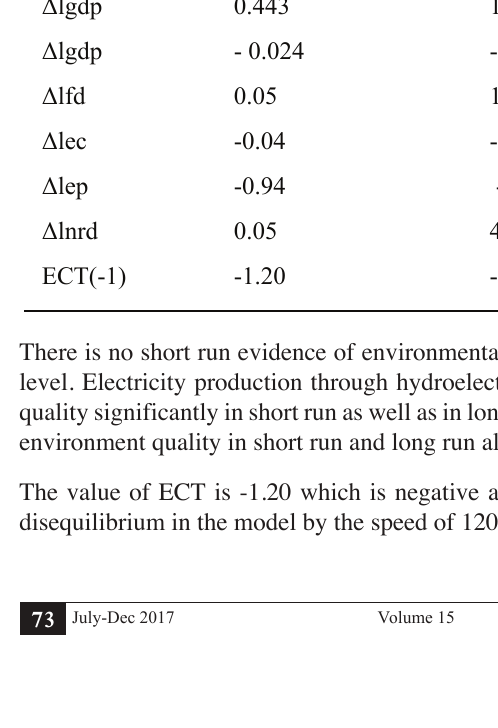
Dependent variable: Δco2 Variables